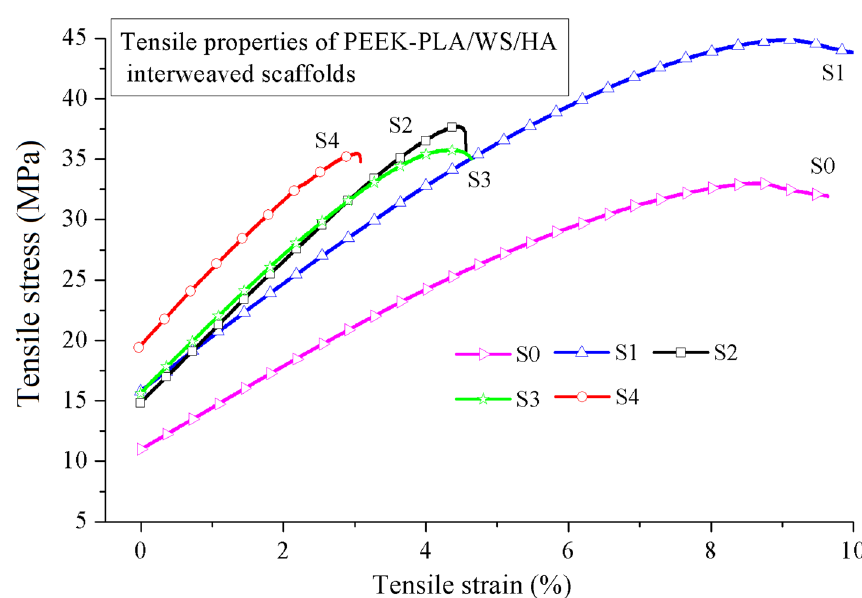
Figure 10. Tensile properties of FFF PEEK-PLA/WS/HA